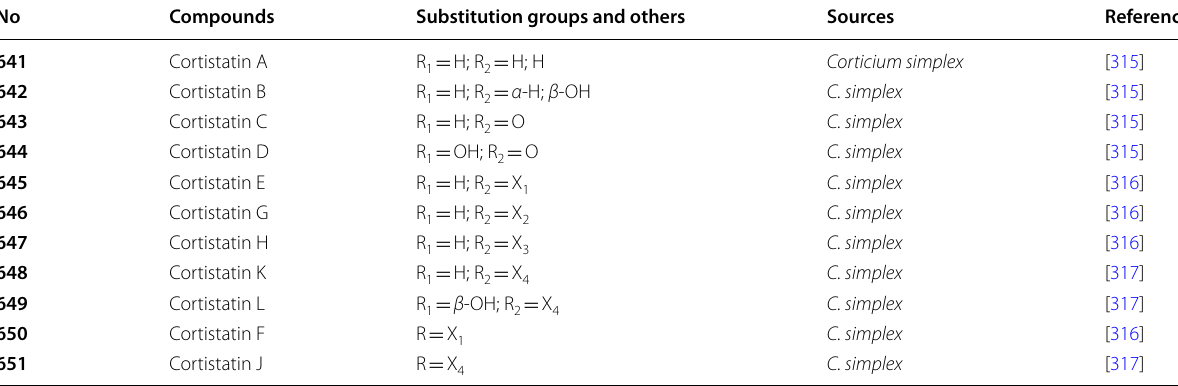
Table 15 Structures and sources of cortistatins 641–651